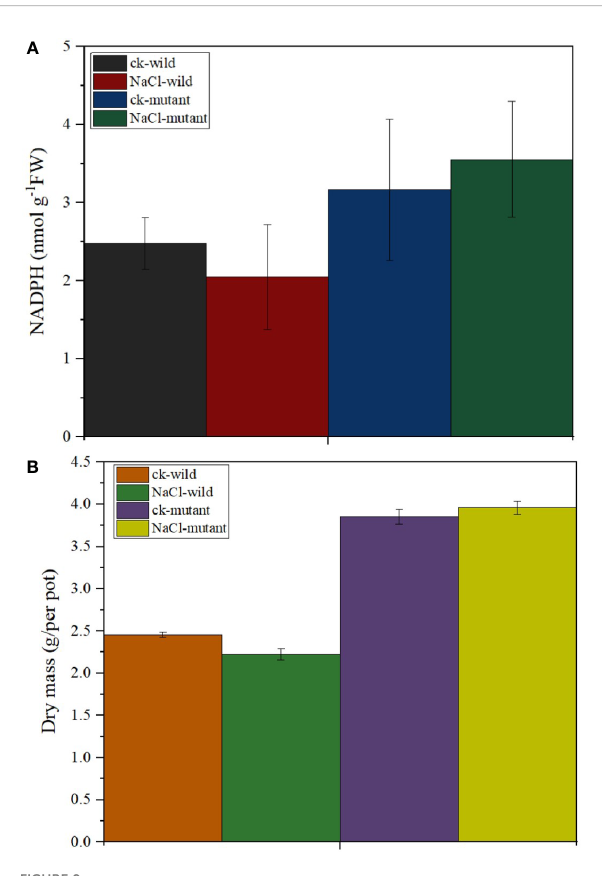
FIGURE 9 (A) Stem-loop secondary structures of MIR171f of bermudagrass. Segments corresponding to the mature miR171f are shown in orange, (B) Morphological variation in the control, wild type, and mutant barrelclover plants. NADPH and dry matter accumulation